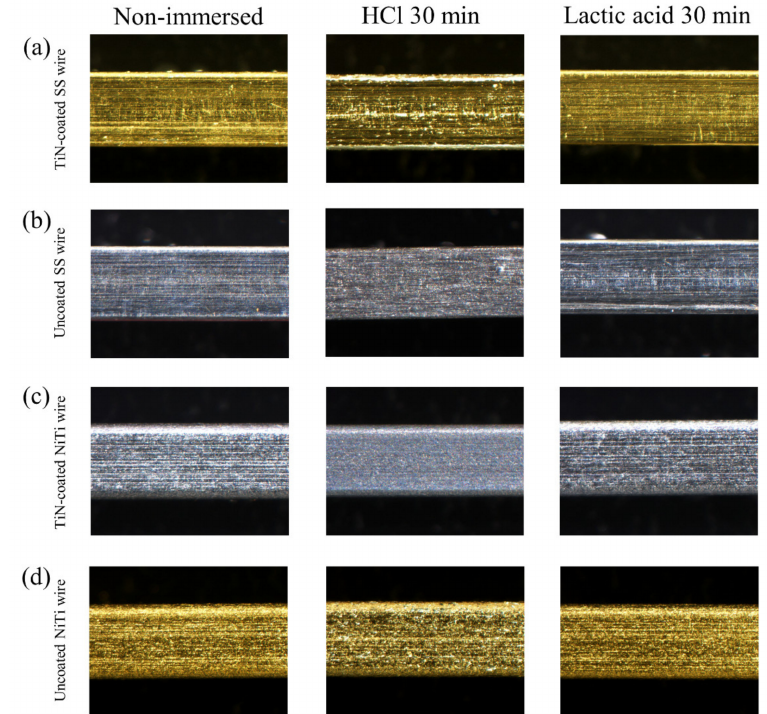
Figure 3. Stereomicrographs of orthodontic wire immersed in HCl or lactic acid for 30 min: ( a ) TiN-coated SS wire; ( b ) Uncoated SS wire; ( c ) TiN-coated NiTi wire; ( d ) Uncoated NiTi